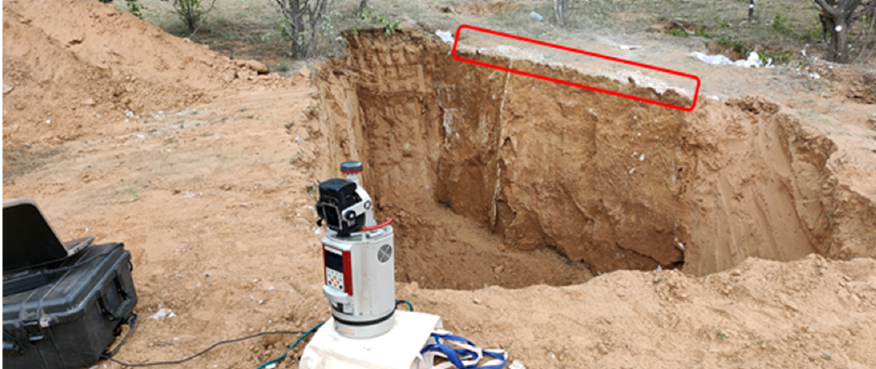
Remote Sens. 2022 , 14 , x FOR PEER REVIEW Figure 6. Field data collection in the western part of the ground fissure. Figure 6. Field data collection in the western part of the ground fissure. Figure 6. Field data collection in the western part of the ground fissure.